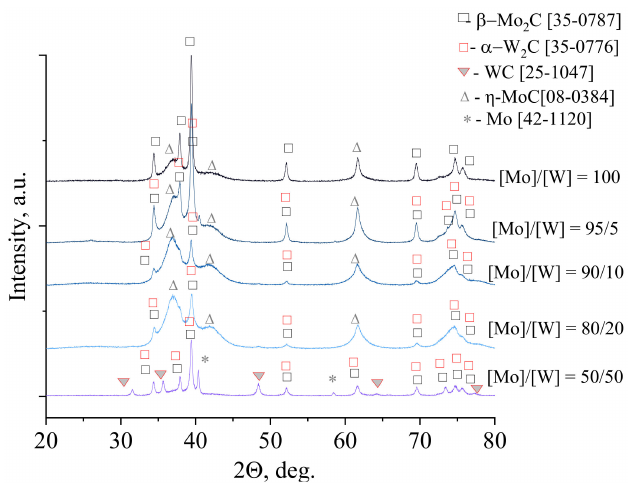
Figure 5. XRD pattern of molybdenum-tungsten carbides with molar ratio [R] / [ Σ Me] = 1 calcined at 900 ◦ C in inert atmosphere.